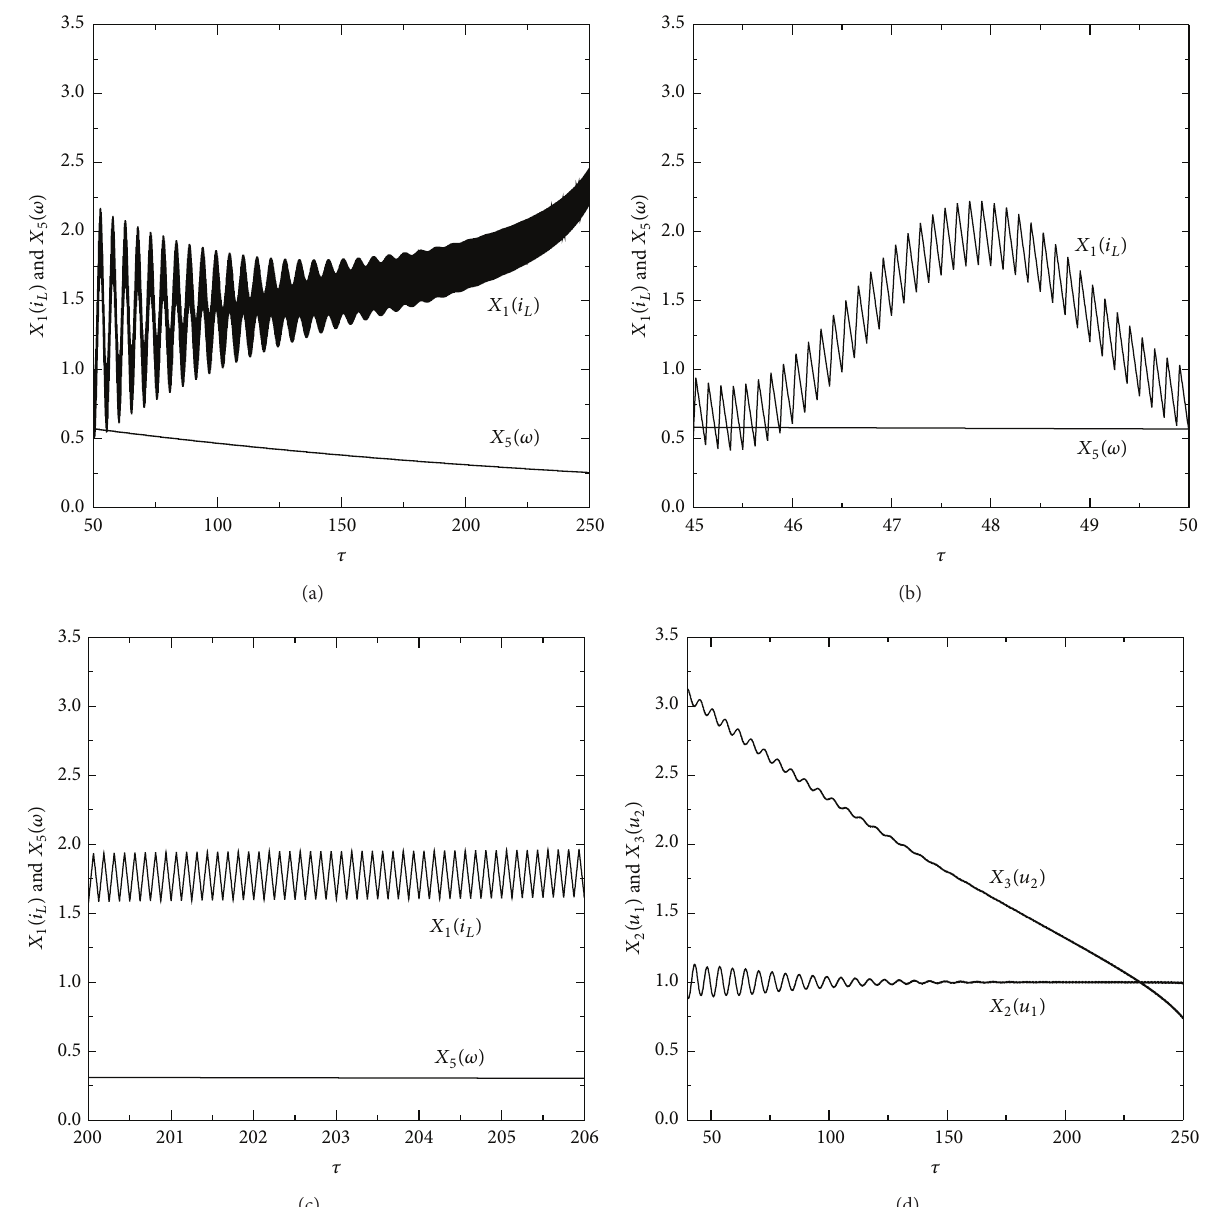
= 10 V, for (a) 𝑋 ref